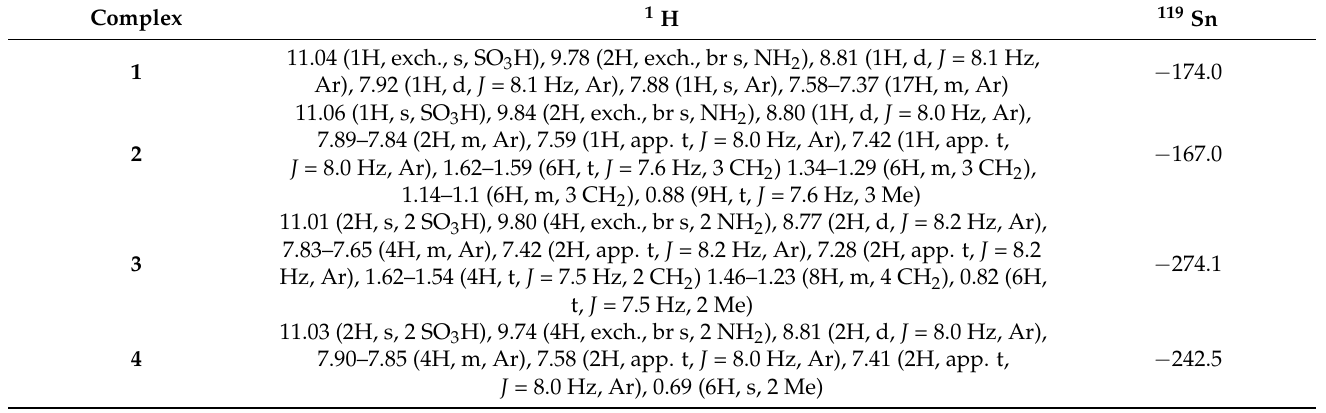
Table 3. 1 H and 119 Sn NMR spectral data (DMSO- d 6 ; ppm, Hz) of tin-naphthalene sulfonic acid complexes 1 – 4